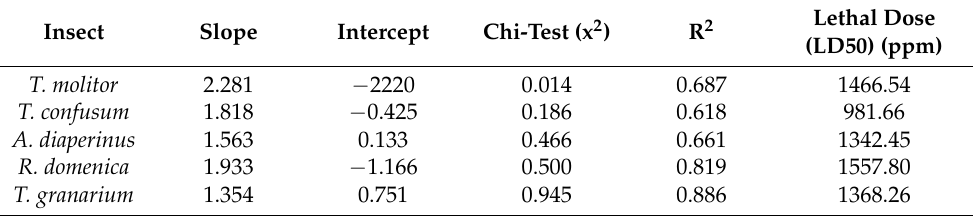
Table 2. LC50 values (slope, intercept, chi-test, R 2 ) of the tested coleopteran adults. Insect Slope Intercept Chi-Test (x 2 ) R 2